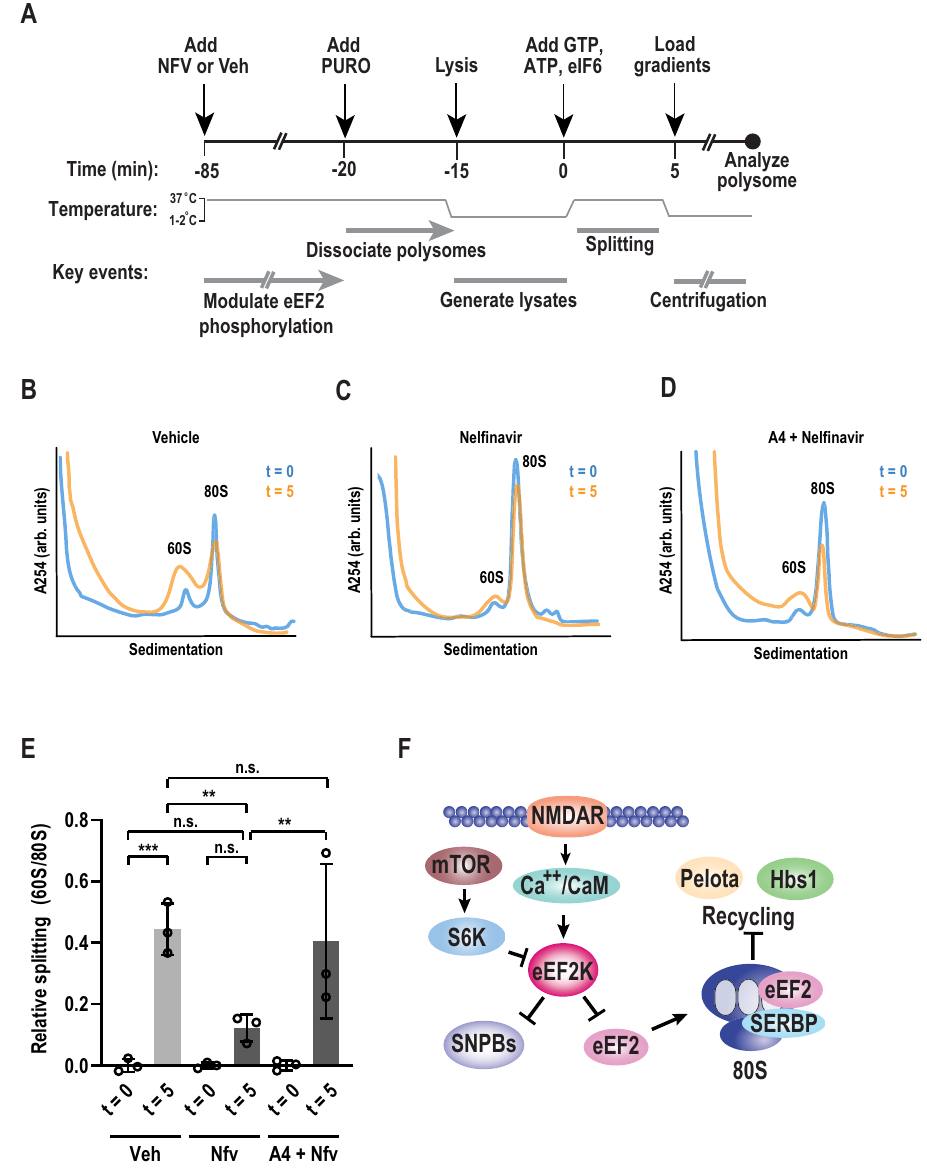
Fig. 7 Nel fi navir-induced monosomes are resistant to recycling. A Schematic diagram of in vitro splitting assay. Cells were treated for 1 h with vehicle (Veh) or nel fi navir (NFV), followed by 50 µ M puromycin (PURO) for 5 min. Cells were then lysed and clari fi ed by centrifugation. Splitting assays were initiated with the addition of ATP (1 mM), GTP (1 mM), and eIF6 (5 µ M), and transferred to 37 °C for 5 min. Reactions were halted by cooling samples on ice before performing polysome pro fi les. B Representative polysome pro fi les from splitting assays following vehicle treatment performed pre-splitting ( t = 0, blue) and post-splitting assay ( t = 5, orange). C Representative polysome pro fi les from splitting assays following nel fi navir treatment performed pre-splitting ( t = 0, blue) and post-splitting assay ( t = 5, orange). D Representative polysome pro fi les from splitting assays in cells pre-treated with A4 (25 µ M) followed by nel fi navir treatment performed pre-splitting ( t = 0, blue) and post-splitting ( t = 5, orange). E Quanti fi cation of relative splitting, as measured by the ratio of 60S peak height to 80S peak height. Initial ratios ( t = 0) were subtracted from corresponding treatment groups. Error bars represent mean ± SD. n = 3 biological replicates. P -value determined by one-way ANOVA. Veh t = 0 vs Veh t = 5 p = 0.0004, Veh t = 0 vs NFV t = 5 p = 0.2039, NFV t = 0 vs. NFV t = 0 p = 0.2039 Veh t = 5 vs NFV t = 5 p = 0.0038, NFV t = 5 vs A4 + NFV t = 5 p = 0.0086, Veh t = 5 vs. A4 + NFV t = 5 p = 0.6673. F A proposed model highlighting eEF2K functions in sensory neurons. Source data are provided as a Source Data fi